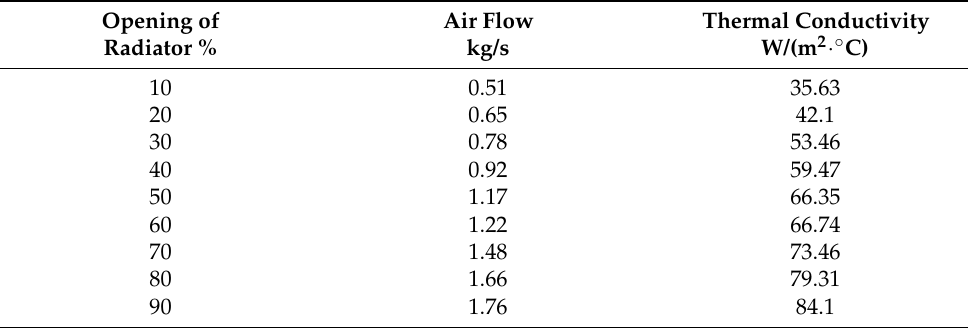
Table 1. Experimental data of heat dissipation